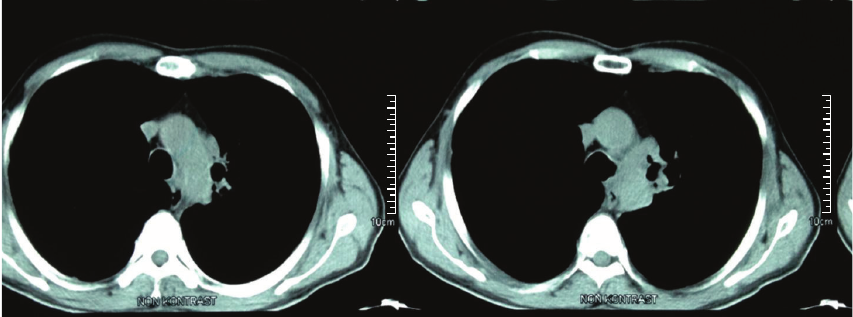
Figure 1: A mass lesion constricting the upper left lobe bronchus with hazy boundaries with the descending aorta observed in the thoracic CT.